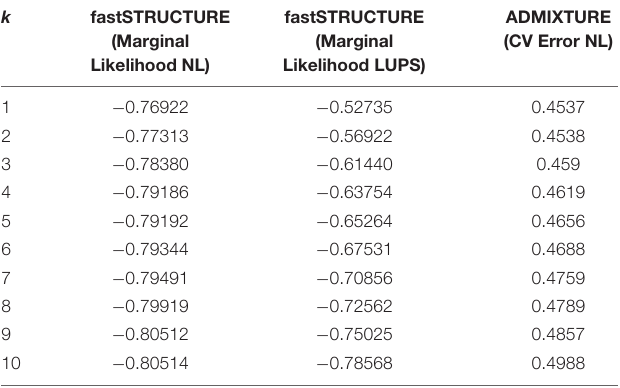
TABLE 5 | fastSTRUCTURE and ADMIXTURE results associated with each possible k of